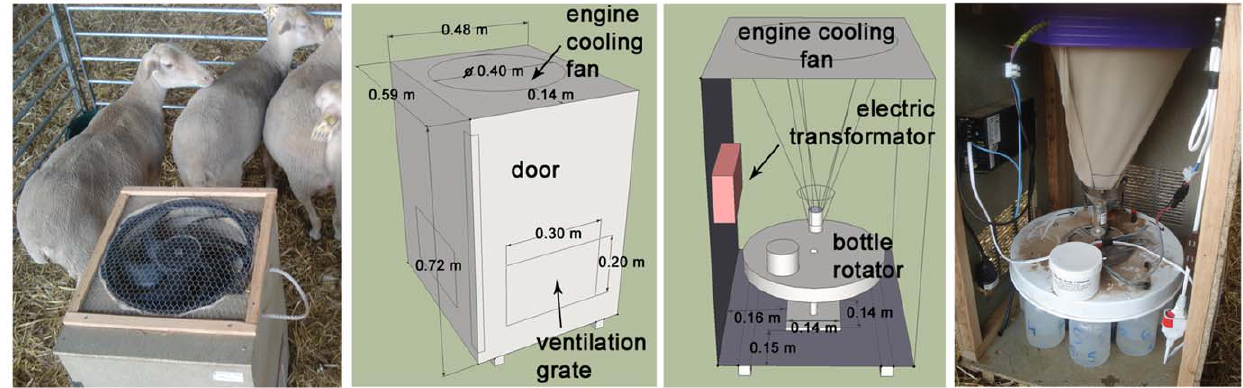
Figure 2. Circadian host-seeking activity of C.brunnicans and C.obsoletus : total number of females collected outdoor by host-baited traps at each session and day time. Small symbols are single collection and lines with large symbols the means by period. Vertical lines symbolize the time of sunrise and sunset. doi:10.1371/journal.pone.0048120.g002 PLOS ONE |